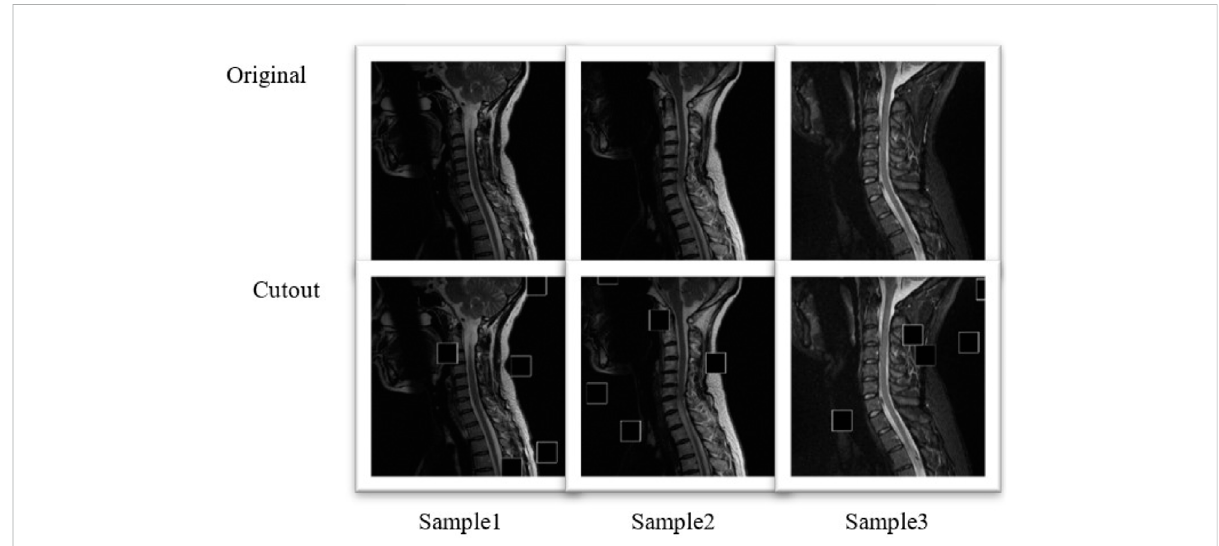
FIGURE 2 Comparison image of the original sample and the augmented sample of the three